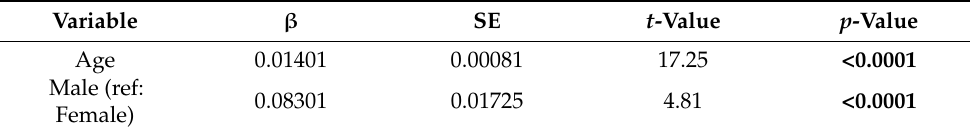
Table 1. Multiple linear regression of Hemoglobin A1c (HbA1c) values associated with age and gender. Variable β SE